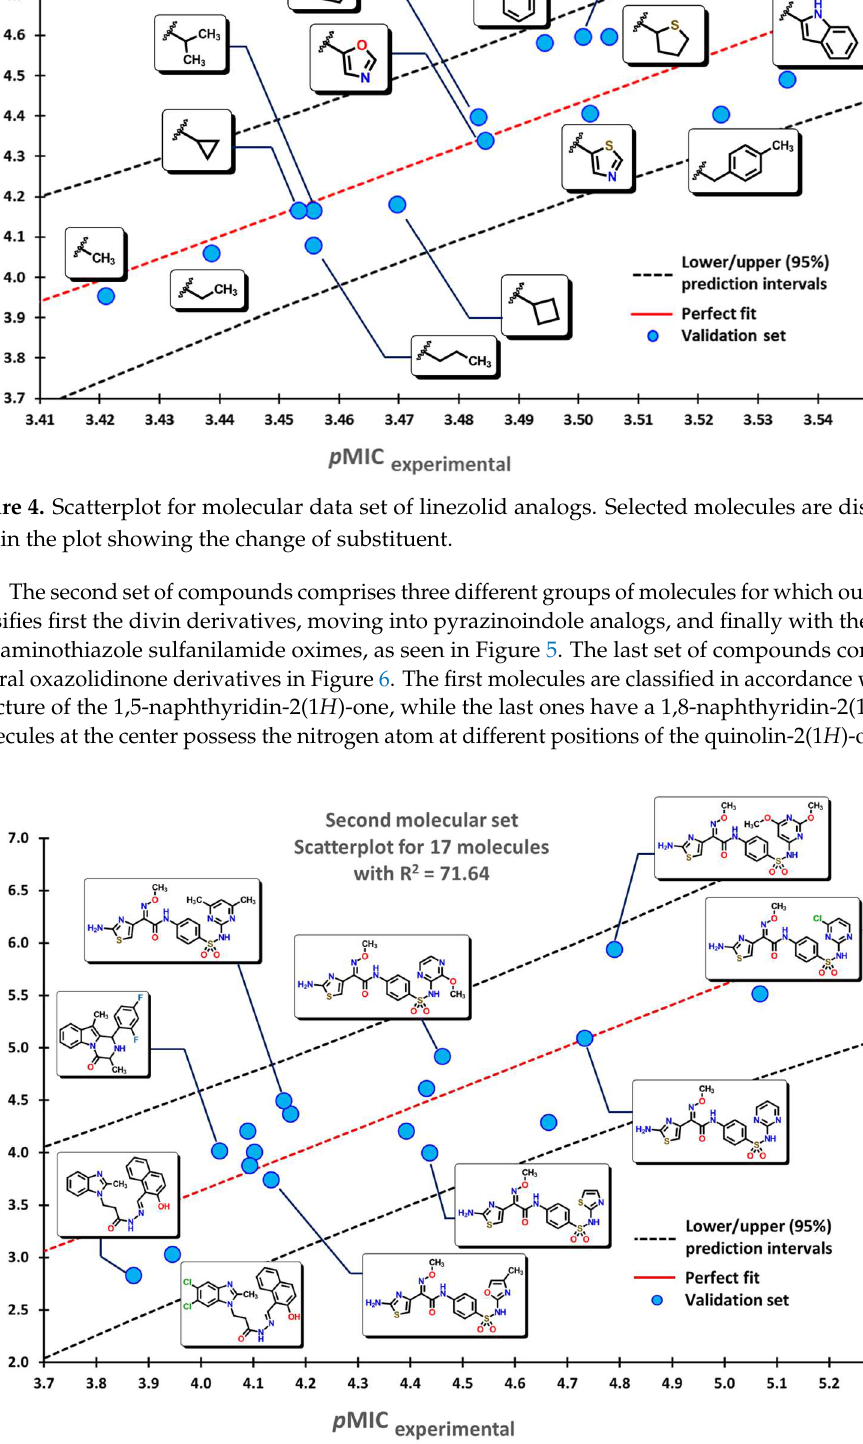
Figure 6. Scatterplot for oxazolidinone derivatives used for the validation of the QSPR model. Se- lected molecules are displayed within the plots. 2.2. QSPR Interpretation The understanding of the descriptors presented by the QSPR model allows us to gain some insights into the chemical features of the molecules used in the model that are rele- vant for their antibacterial activity towards A. baumannii . Equation (1) displays two topo- logical descriptors (D/Dr06 and TI2), one 2D-autocorrelation (GATS6m), six functional